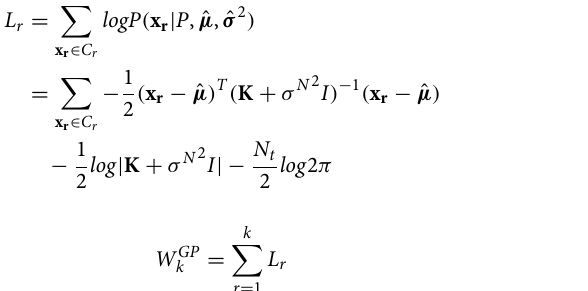
that is an expected log ( W k ) under a null reference distribution from randomly sampled data. Reference data are sampled within the same range of observed data such that there is no obvious clustering pattern. TRACS uses adapted gap statistics (hereafter referred to as Gaussian gap statistics ) as a metric for within-cluster variance to reflect temporal dependency in gene expression. We assume that gene expressions in a cluster are generated from µ a Gaussian process. Cluster mean ˆ = point t i are estimated using the expression vectors of all genes x in the cluster including the replicated